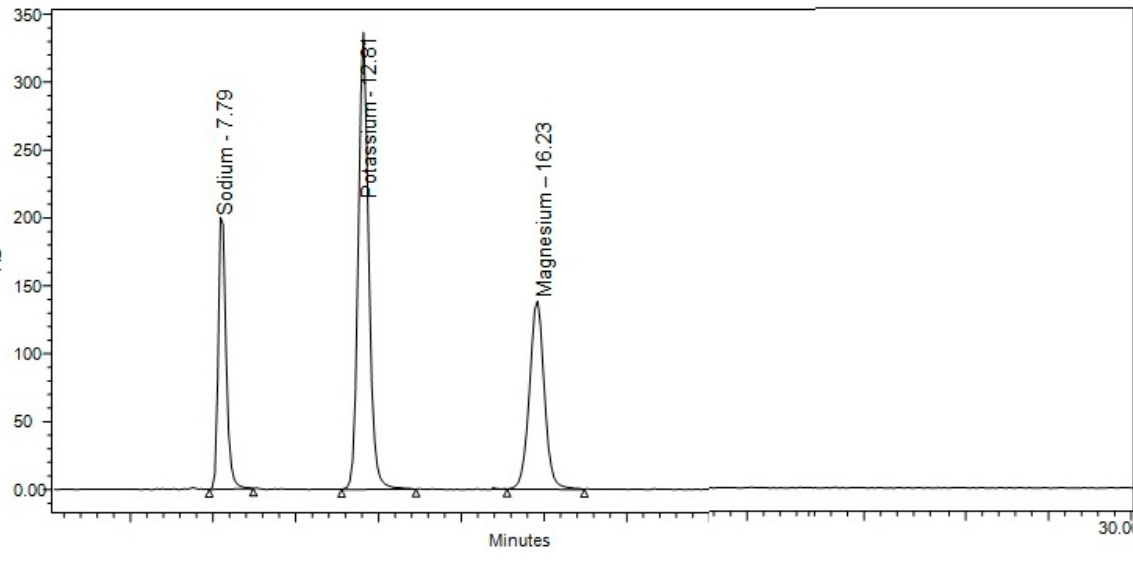
Figure 1. Chromatogram showing separation of the analytes under study.